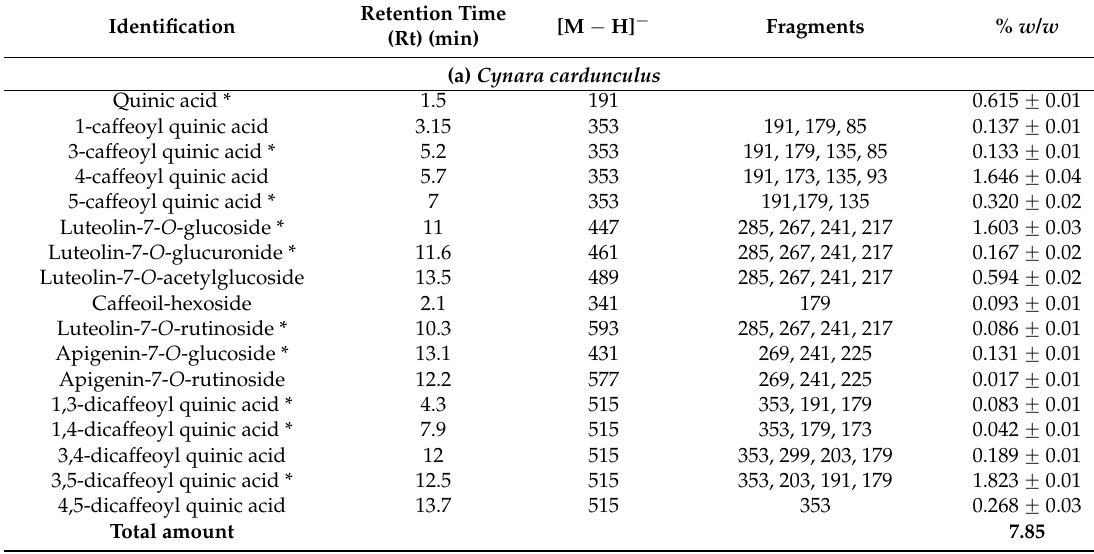
Identification of constituents and quantification from Cynara cardunculus ( a ) and Agrimonia eupatoria ( b